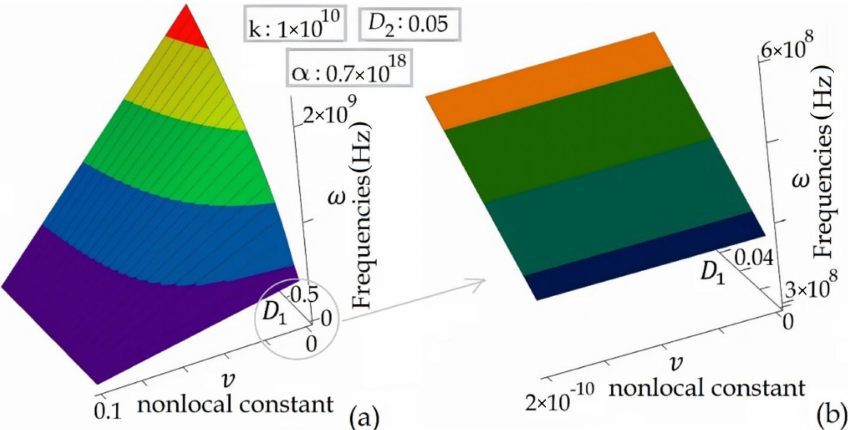
Figure 9. ( a ) The Mode 2 frequencies of EM wave propagation in the DWCNT for the various material parameters, D 1 and the nonlocal constants, ν , ( b ) Zoomed version.